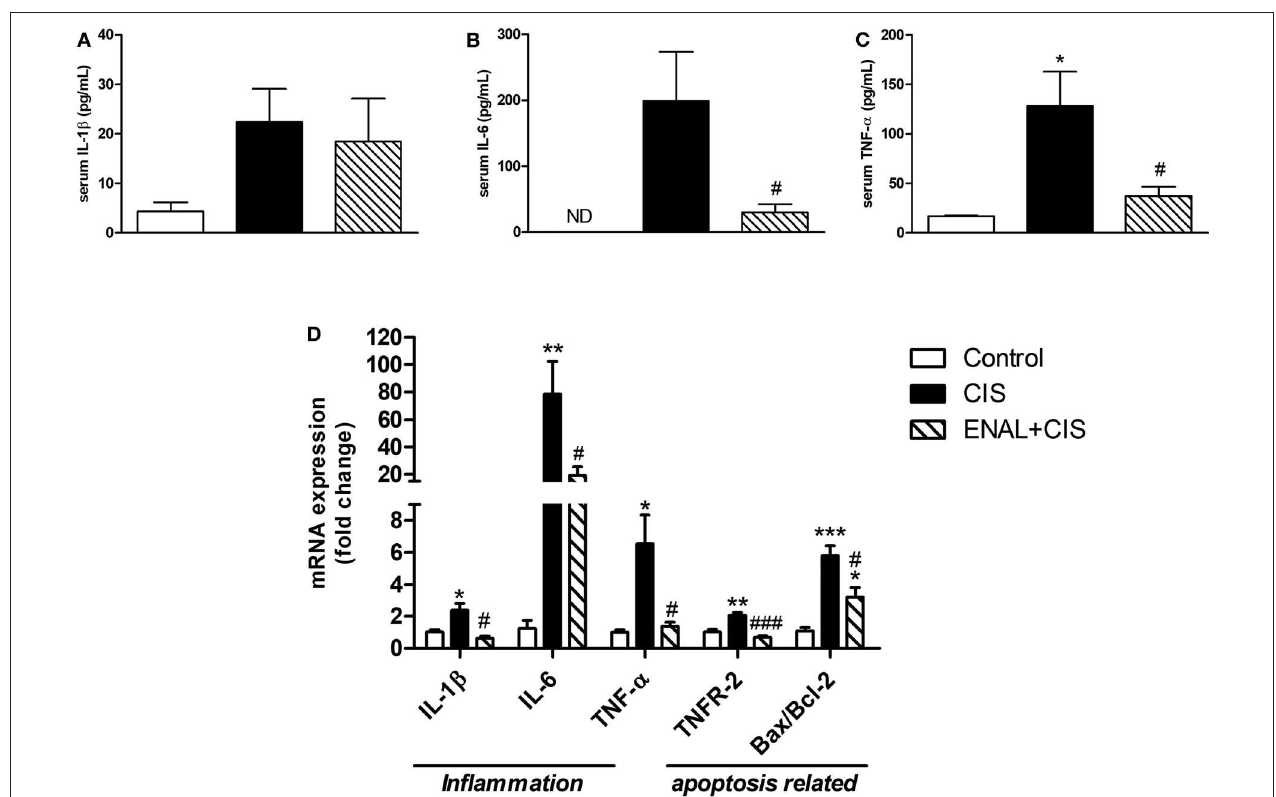
FIGURE 2 | Analysis of serum levels of cytokines and kidney expression of cytokines and apoptotic markers mRNA. (A–C) serum levels of pro-inflammatory cytokines; (D) mRNA expression of cytokines and receptors involved in inflammation and mRNA expression ratio of pro- and anti-apoptotic proteins 4 days after cisplatin treatment. * p < 0.05, ** p < 0.01, *** p < 0.001. compared to the control group. # p < 0.05; ### p < 0.001. compared to the CIS group. Data presented as Mean ± SEM n =